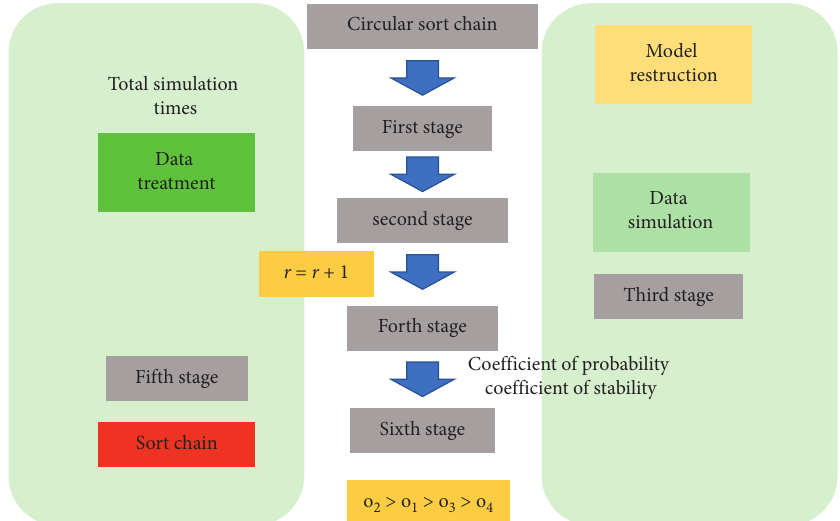
Figure 3: English intelligent question-and-answer system model.